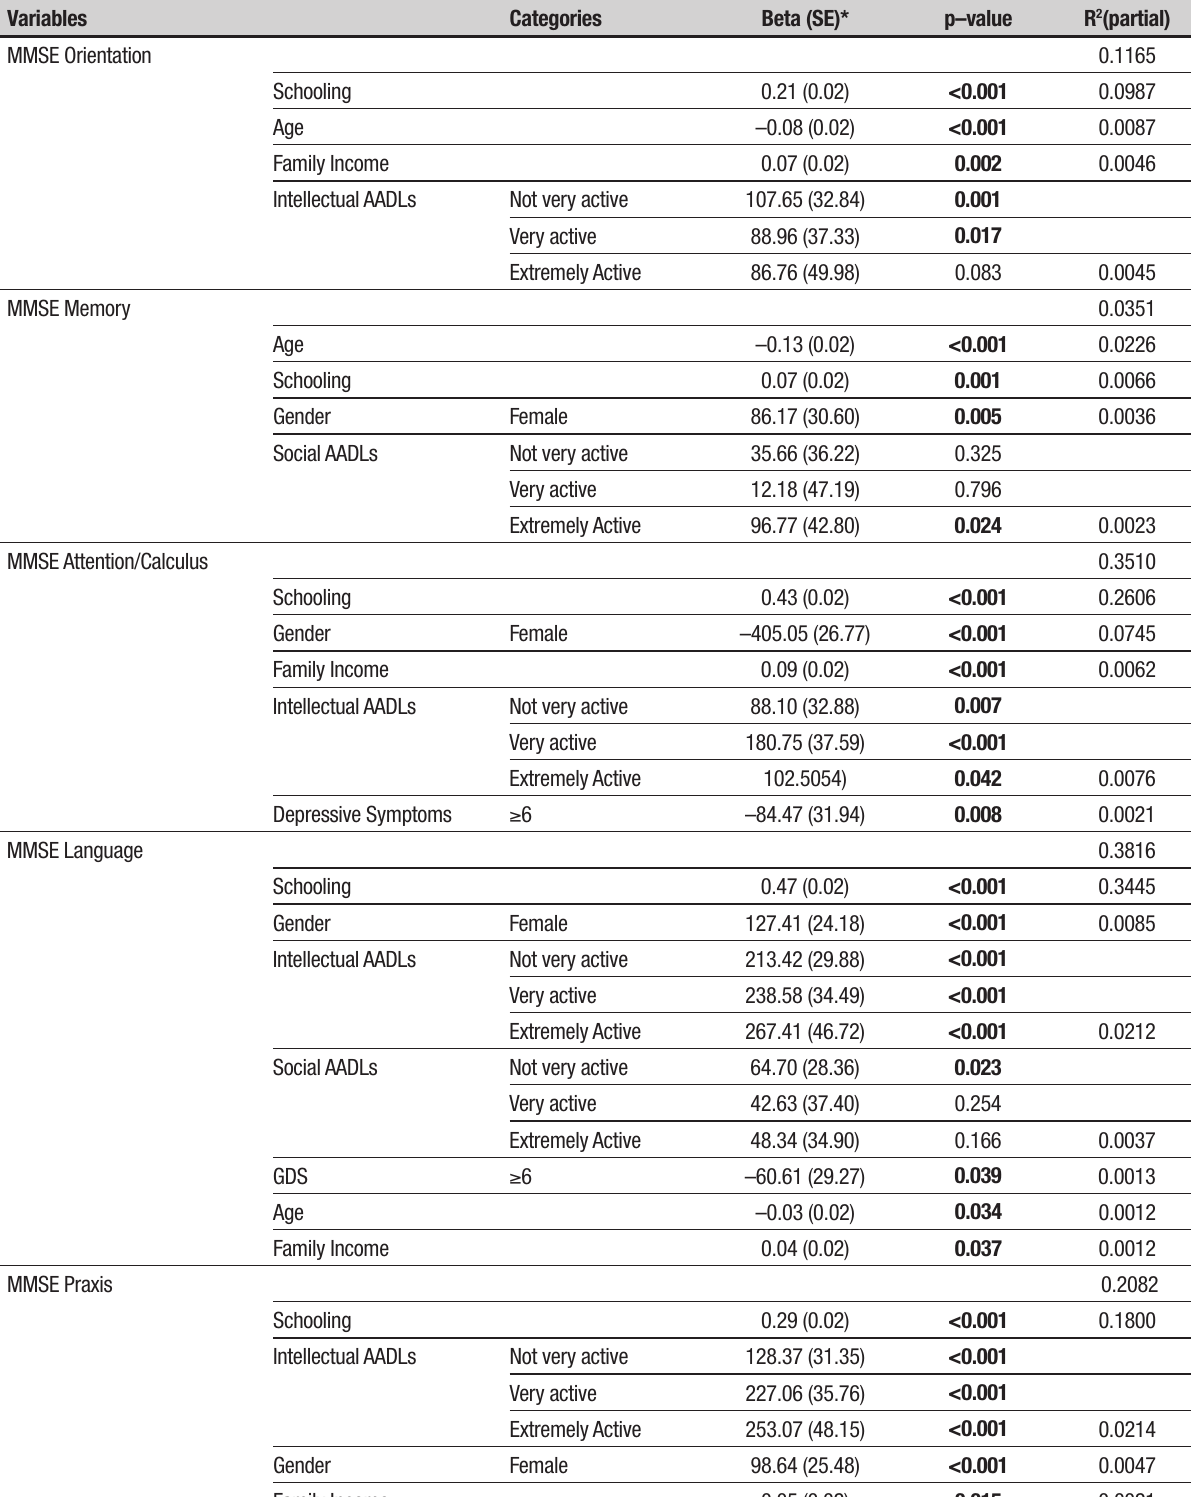
Table 3. Multivariate linear regression analysis with sociodemographic variables, number of diseases reported, depressive symptoms and AADLs (social and intellectual) as independent variables and score on the 5 MMSE domains as dependent variables (n=2193). FIBRA network, Unicamp,